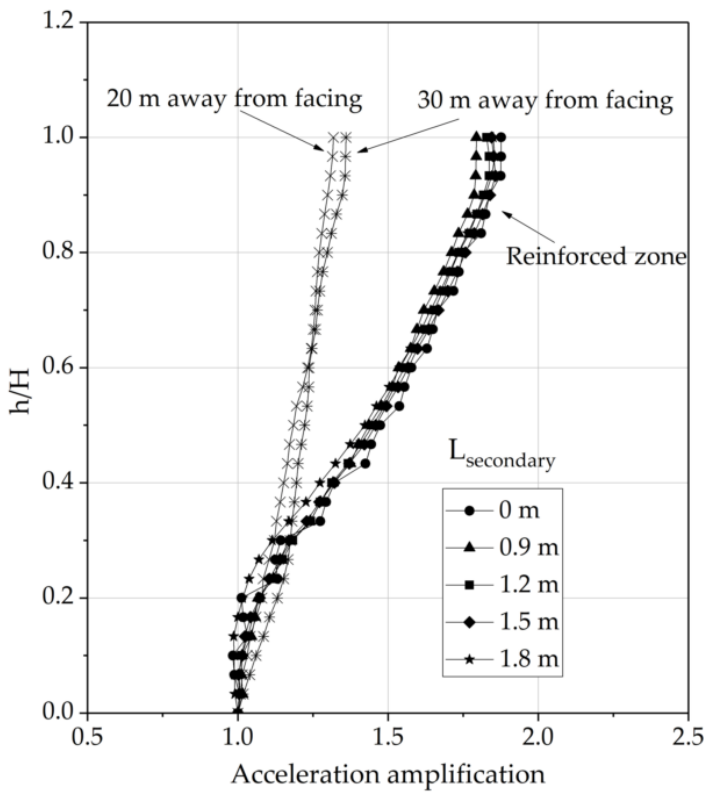
Figure 13. The e ff ect of the secondary reinforcement length on variations of acceleration Figure 13. The effect of the secondary reinforcement length on variations of acceleration amplification.